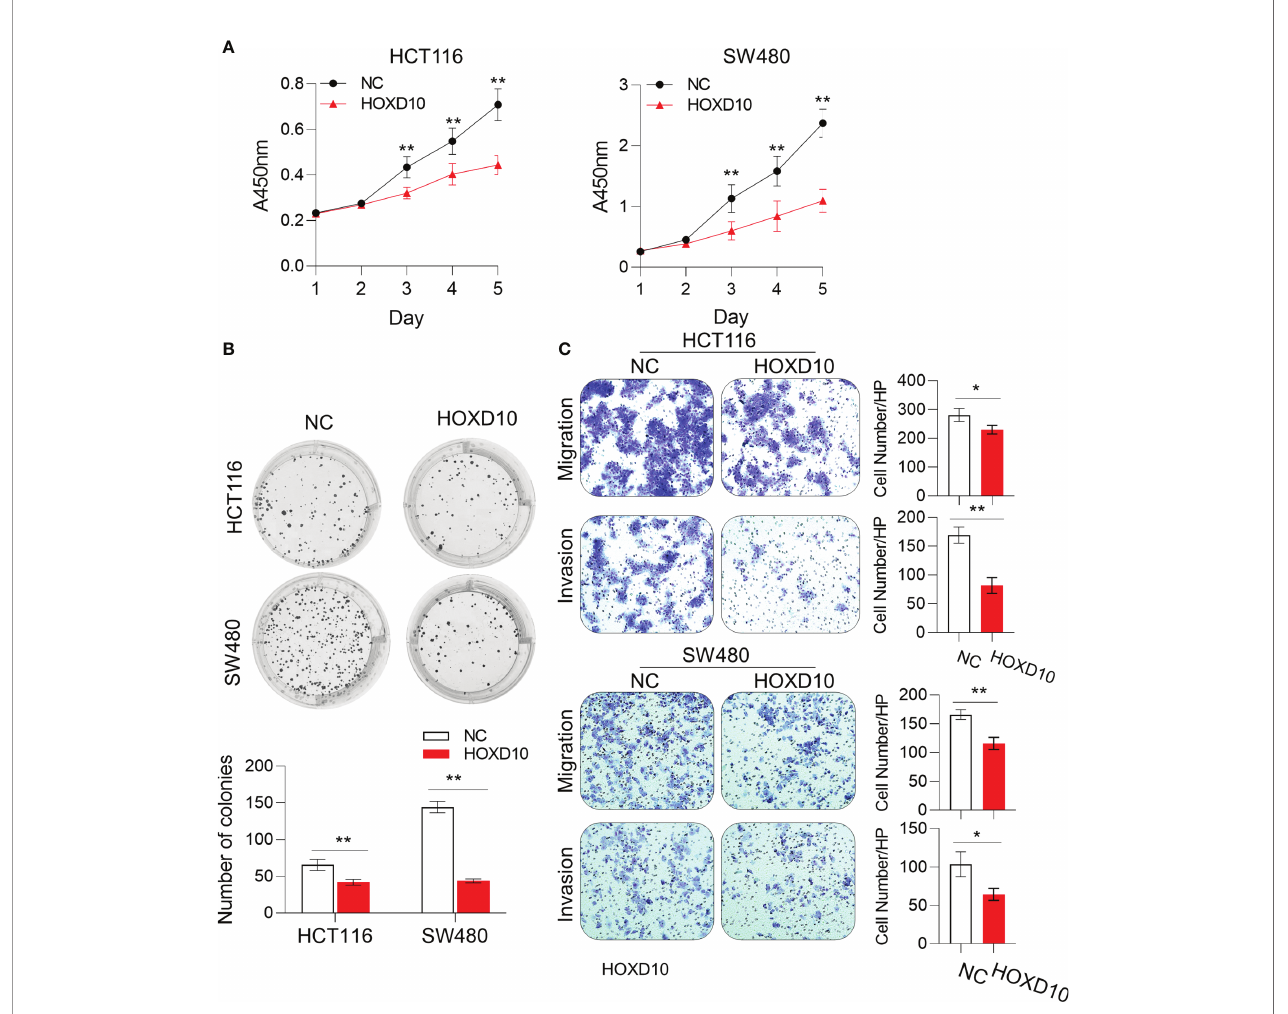
FIGURE 3 | HOXD10 inhibited cell growth, colony formation, and migration and invasion. HCT116 and SW480 cells were transfected with either HOXD10 overexpression plasmids or control empty plasmids. HOXD10 -expressing cells and control cells were then used for the CCK-8 assay (A) , colony formation assay (B) , and migration and invasion assays (C) . * p < 0.05, ** p < 0.01 (independent t -test comparing control and treated